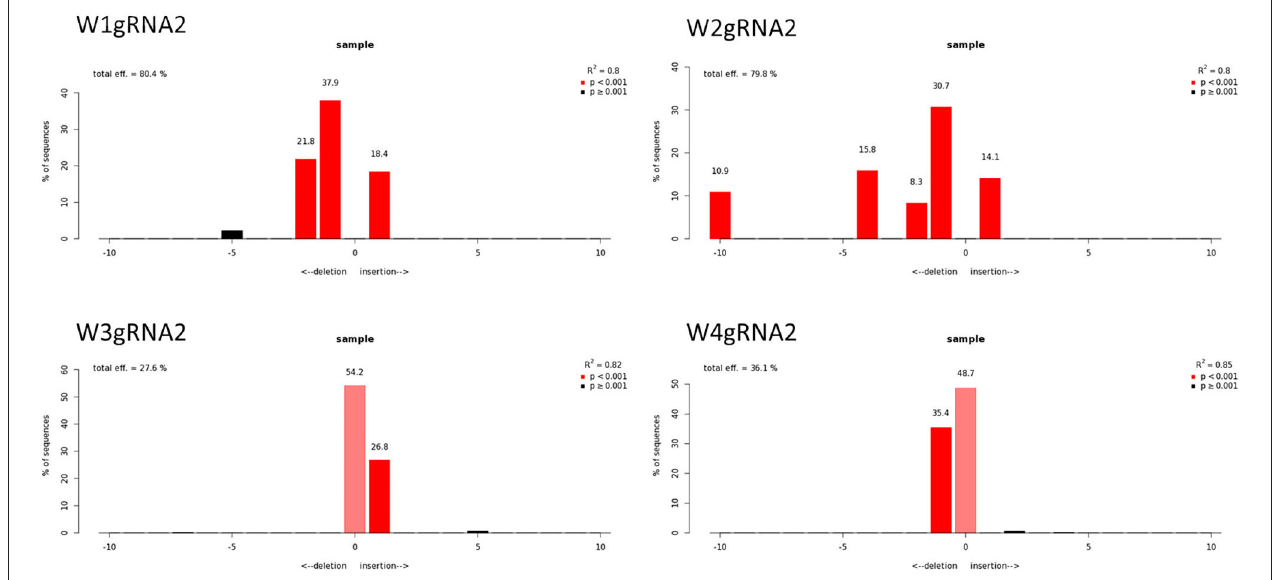
FIGURE 7 | Genotyping of targeted gene mutations induced by CRISPR/Cas9 on gRNA2 in the transformed lines (W1–W4). Editing efficiency and mutagenesis frequencies are reported.